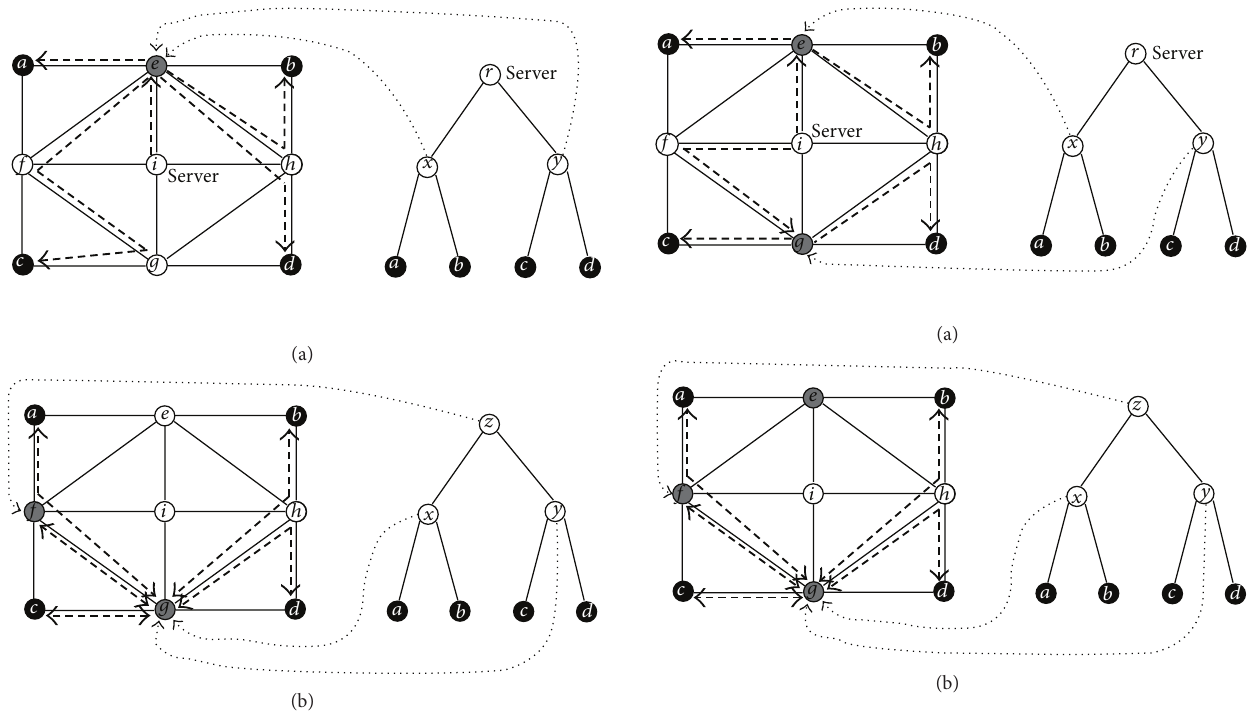
Figure 4: The example network for MRMP and the binary tree topologyareboththesameasthoseshowninFigure1andtheinteger on every edge represents the parameter of the linear probability function. The maximum reliability multicast tree for the centralized MRMP is drawn with the bold dashed edges on the top subfigure and the one for the decentralized MRMP is drawn on the bottom